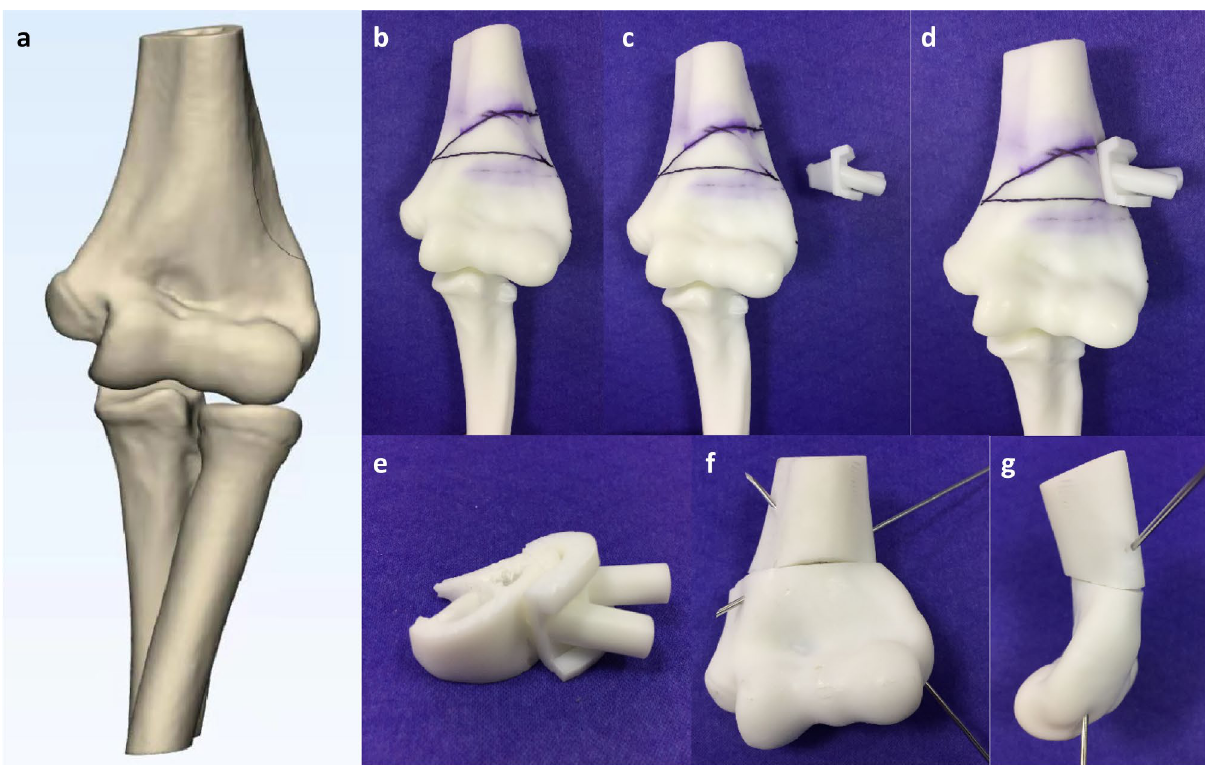
Figure 2. Three-dimensional reconstructed models of the humerus, radius, and ulna ( a ). Simulation of the process of correction preoperatively: the 3D printing model of humerus, marking osteotomy line and with 3D printing template [( b) , ( c ) and ( d )]; the osteotomy template removed with an osteotomized bone wedge ( e ); anteroposterior ( f ) and lateral view ( g ) after reduction of the distal segment of the